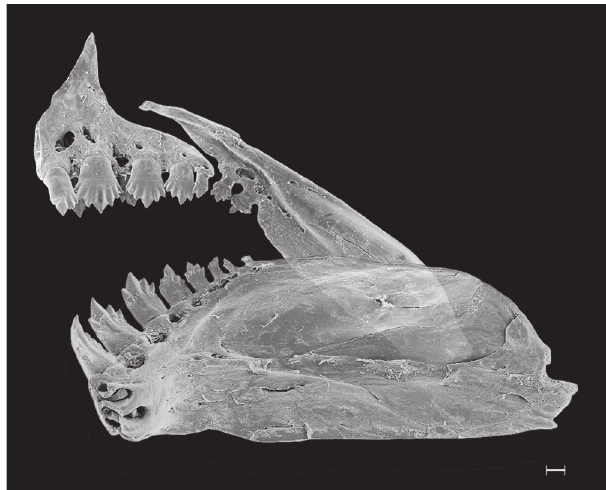
Fig. 3. Hyphessobrycon peugeoti new species, paratype, MNRJ 29609, 27.3 mm SL: left premaxillary, dentary, and maxillary bones in mesial view. Scale bar: 100 μ m.